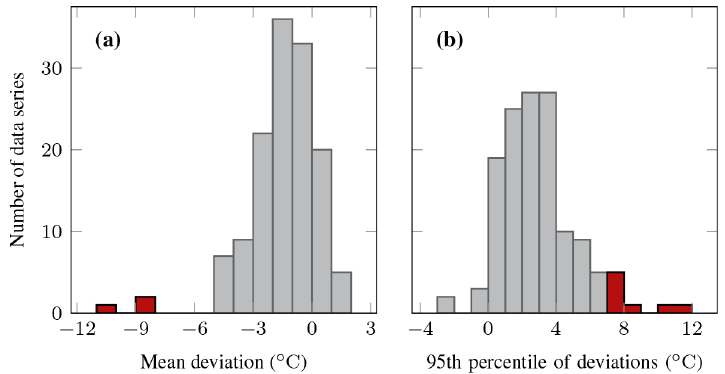
Figure A1. Histograms of the deviation of topsoil temperature minus air temperature in summer; (a) mean and (b) 95th percentile of the deviations for each sensor in each measurement period; data series coloured in red were removed from the analysis because (a) the average deviation was less than − 5 ◦ C, indicating that the sensor was either buried too deep and affected by the permafrost or affected by running water (three series) or (b) more than 5% of the single summer measurements were more than 7 ◦ C above air temperature, indicating additional